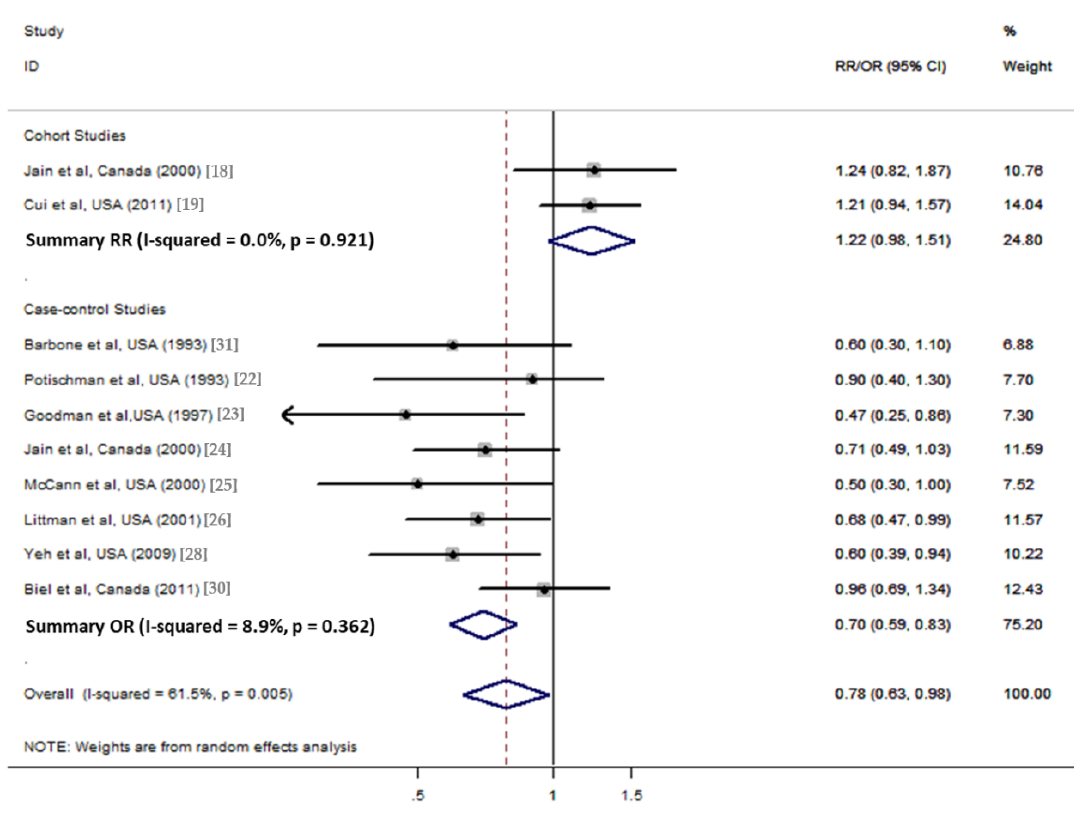
Figure 4. Forest plot of the summary risk estimate of endometrial cancer in the highest category of total dietary fiber intake compared with those in the lowest category of studies in North America.